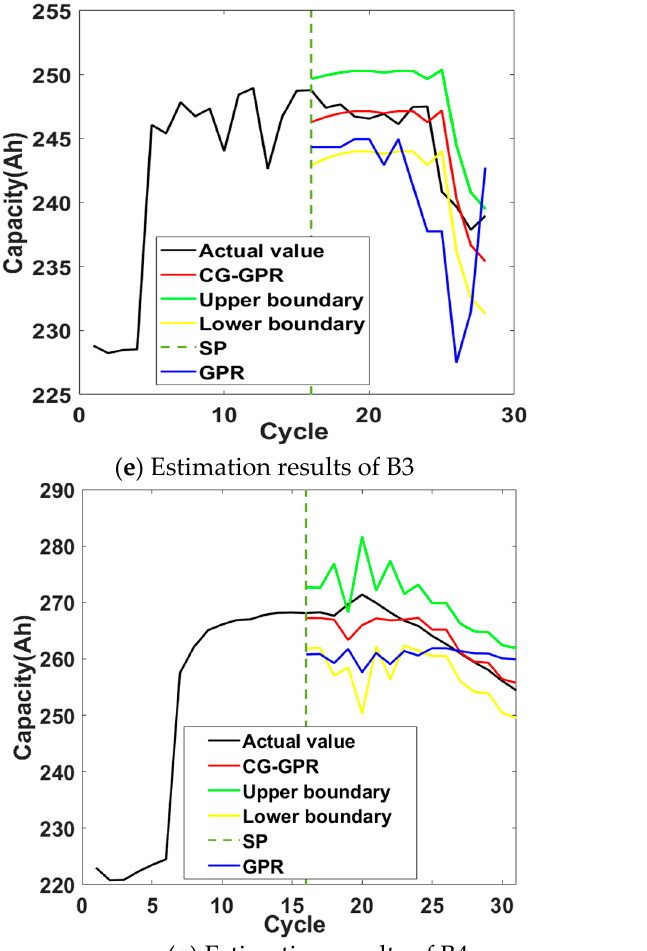
Table 3. The error results